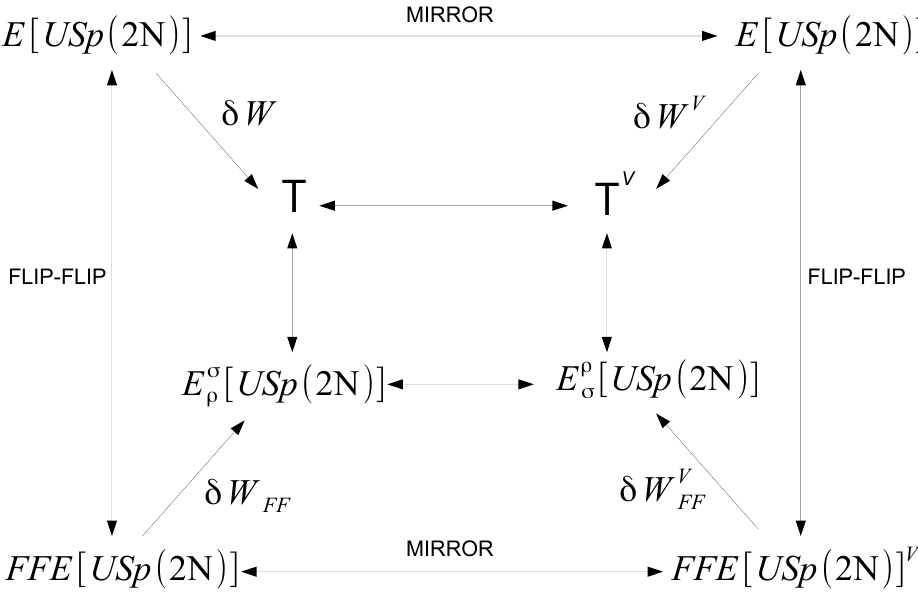
Figure 6 . Deformed duality web for E [USp(2 N